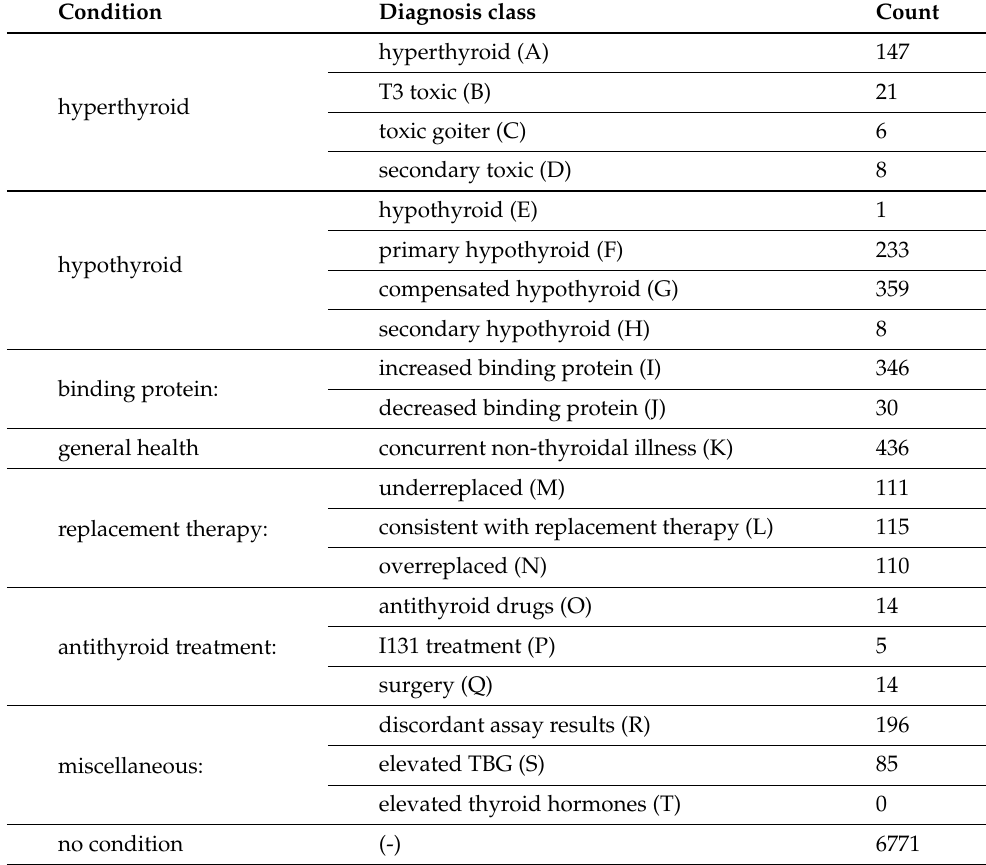
Table 4. Description of the class-wise target.